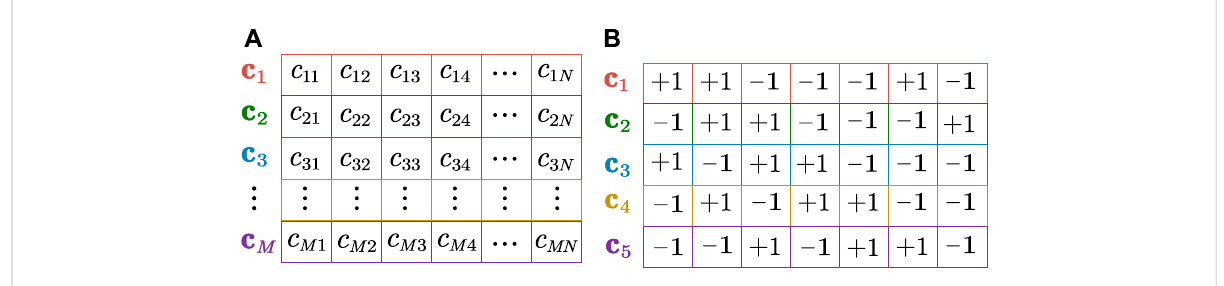
FIGURE 8 m-sequence codebook. (A) m-sequence codebook. (B) N = 7, M = 5.